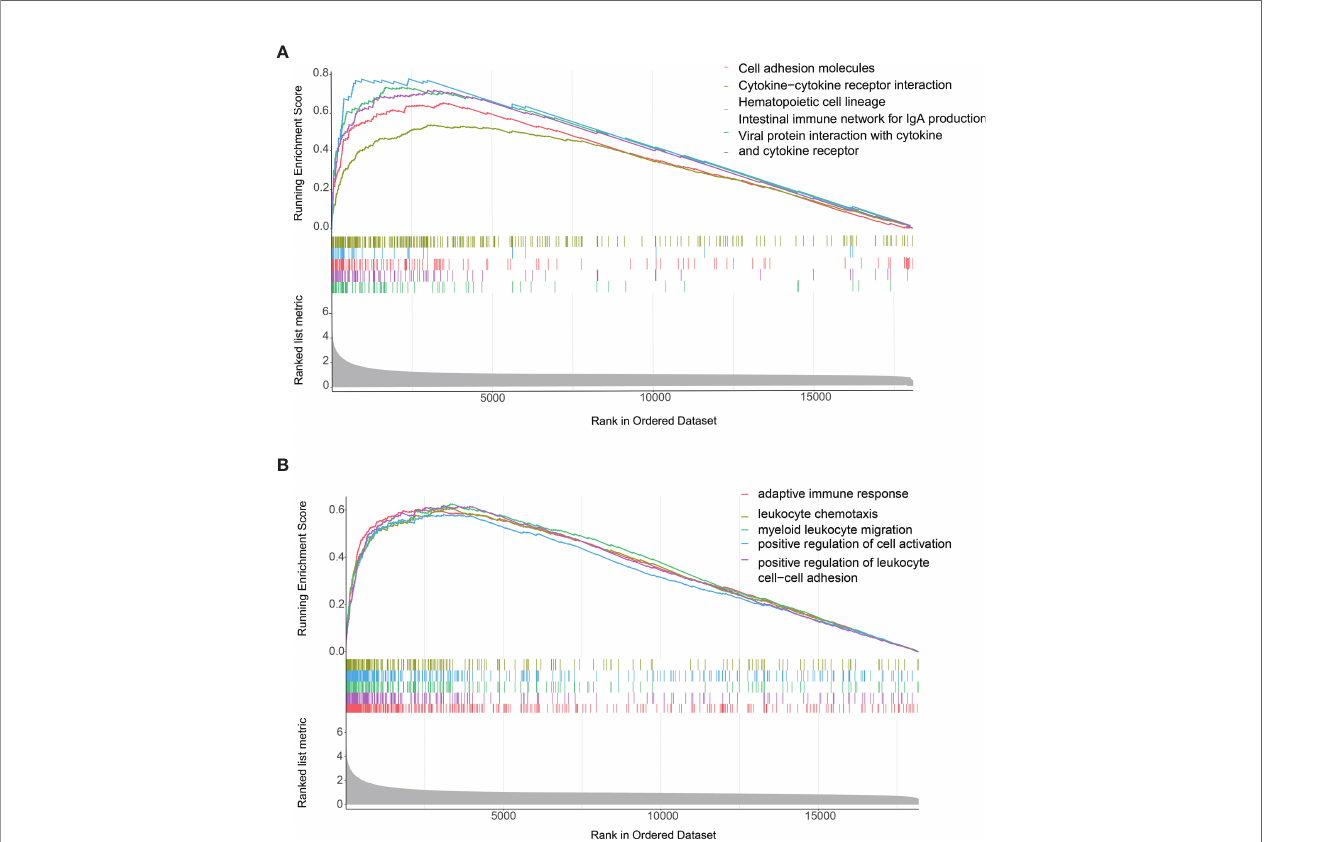
FIGURE 3 | Functional annotation of the two immune in fi ltration subtypes. (A, B) Top enriched gene pathways/functions in distinct immune risk signature groups from the AEG cohort were assessed by using the GSEA